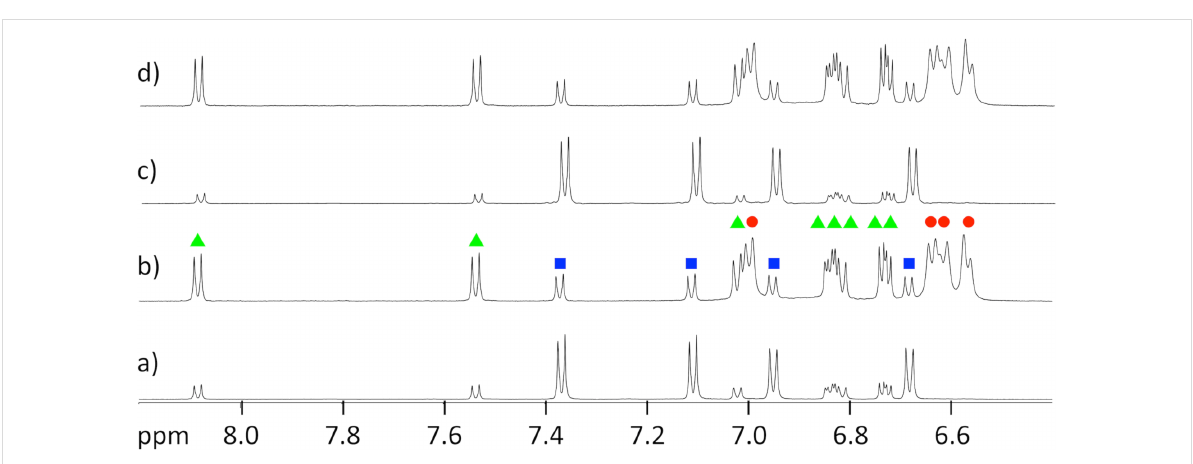
Figure 5: Section from the 1 H NMR spectra of the foldable container 10 in MeOD at 600 MHz: a) after synthesis, b) after irradiation with light of the wavelength λ = 365 nm, c) after irradiation with light of the wavelength λ = 405 nm and d) after irradiation with light of the wavelength λ = 365 nm. The protons of the isomers trans , trans - 10 (blue squares), cis , trans - 10 (green triangles) and cis , cis - 10 (red circles) are marked.